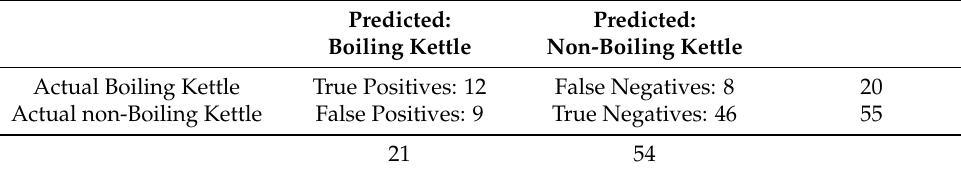
Table 4. Neural network confusion matrix without context reasoning.